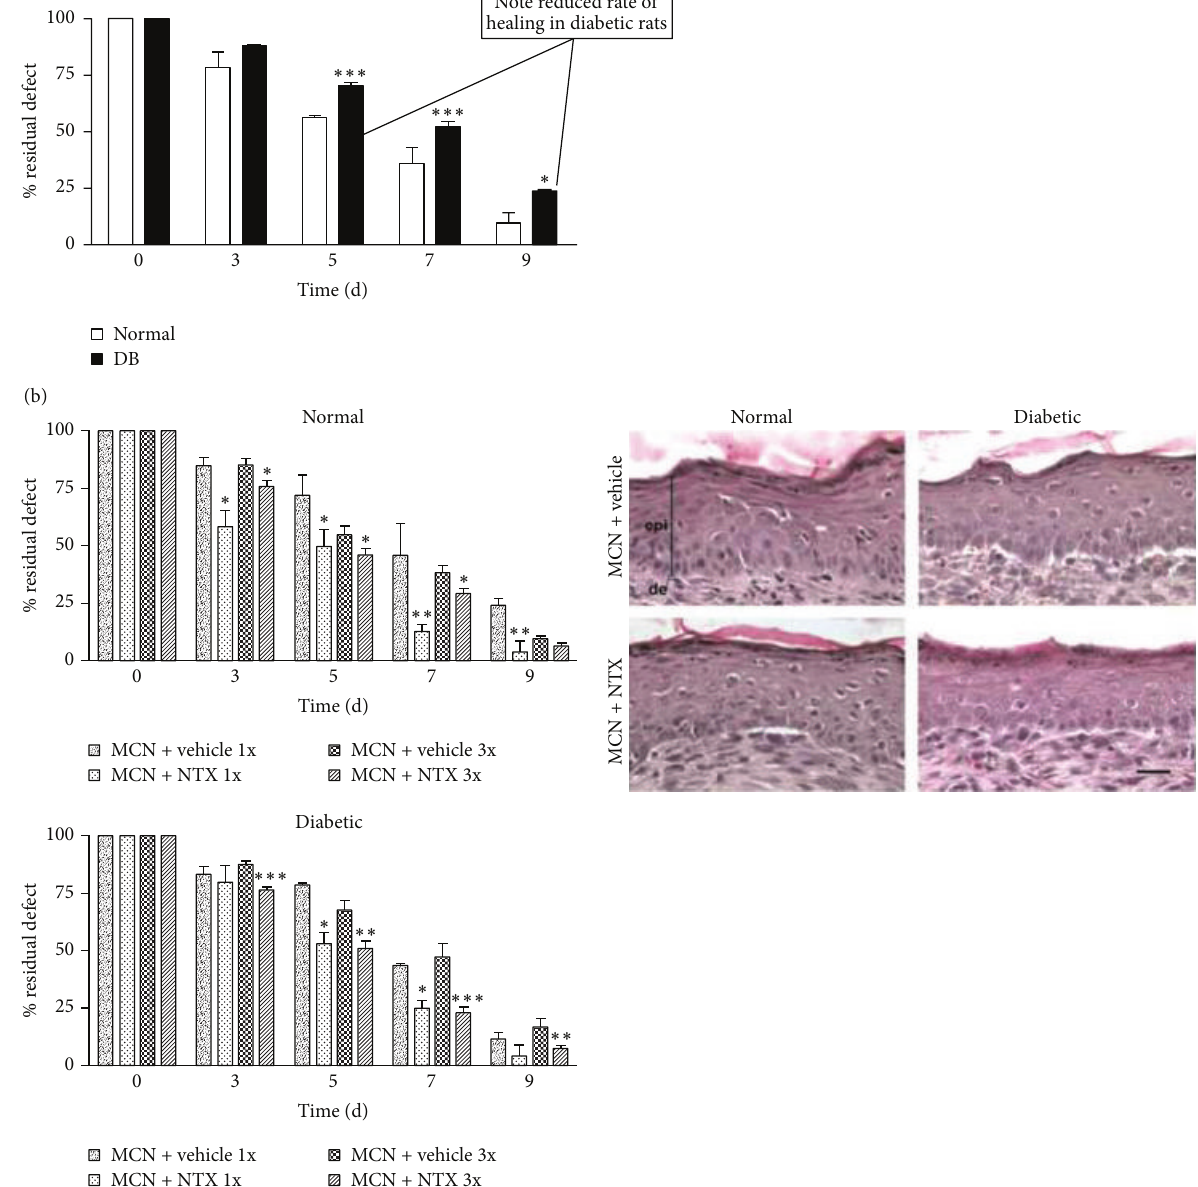
Figure 18: Effect of NTX treatment on wound healing rate of standardized skin wounds. Left: the impact of daily or three times daily NTX in moisturizing cream (MCN) on the healing rate of standard cutaneous wounds. Left (a): untreated diabetic rats had skin wounds that were 24%, 44%, and 132% greater than those of normal animals on days 5, 7, and 9, respectively, after wounding. Left (b, upper): within three days of a single or three times daily regimen of 10 −5 M NTX in MCN, the wounded areas of normal rats were reduced by 30% and 11%, on the respective days, compared to other normal animals receiving MCN + vehicle. Left (b, lower): diabetic (DB) animals subjected to once daily application of MCN + NTX had a decreased wound size compared with DB rats exposed to vehicle, but the greatest effect was achieved with MCN + NTX given three times daily, which consistently accelerated wound closure, resulting in mean residual wounds that were reduced by 13% to 57% from DB rats treated with MCN + vehicle. Values represent means ± SEM. Significantly different from normal or MCN + vehicle at ∗ 𝑃 < 0.05 , ∗∗ 𝑃 < 0.01 , and ∗∗∗ 𝑃 < 0.001 . Right: histology of skin comparing normal and DB rats receiving vehicle or NTX. The overall appearance is similar, without evidence of necrosis, and so forth. Nevertheless, epithelial thickness in normal rats ( 24.6 ± 1.6 𝜇 m) was 44% greater than in DB rats receiving vehicle. Normal animals treated with NTX, as well as DB rats subjected to NTX, did not differ in the thickness of the epithelium relative to normal animals receiving vehicle (derived from